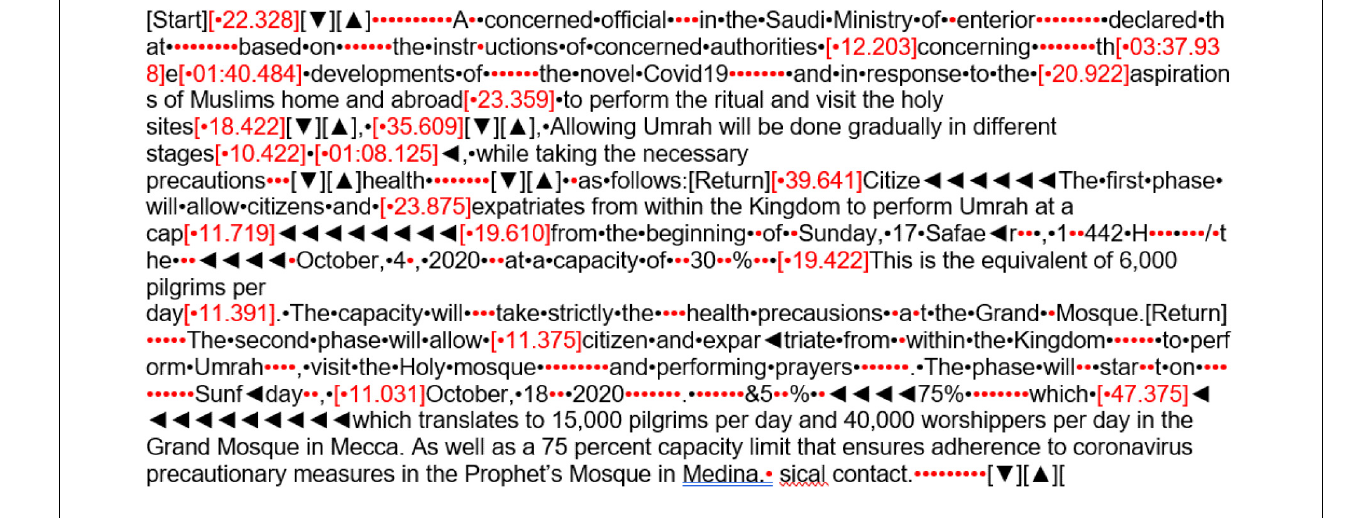
items such as “mustajd¯at” and “muq¯ım” as well as for expressions al-ijr¯a’¯at al-ih.tr¯aziyah al- and sentences such as “m‘a itikh¯ad ¯ s.ih.yah” and “tat.lu‘ kat ¯¯ır min al-muslim¯ın f¯ı al-d¯ah ¯il walh ¯¯arij”.